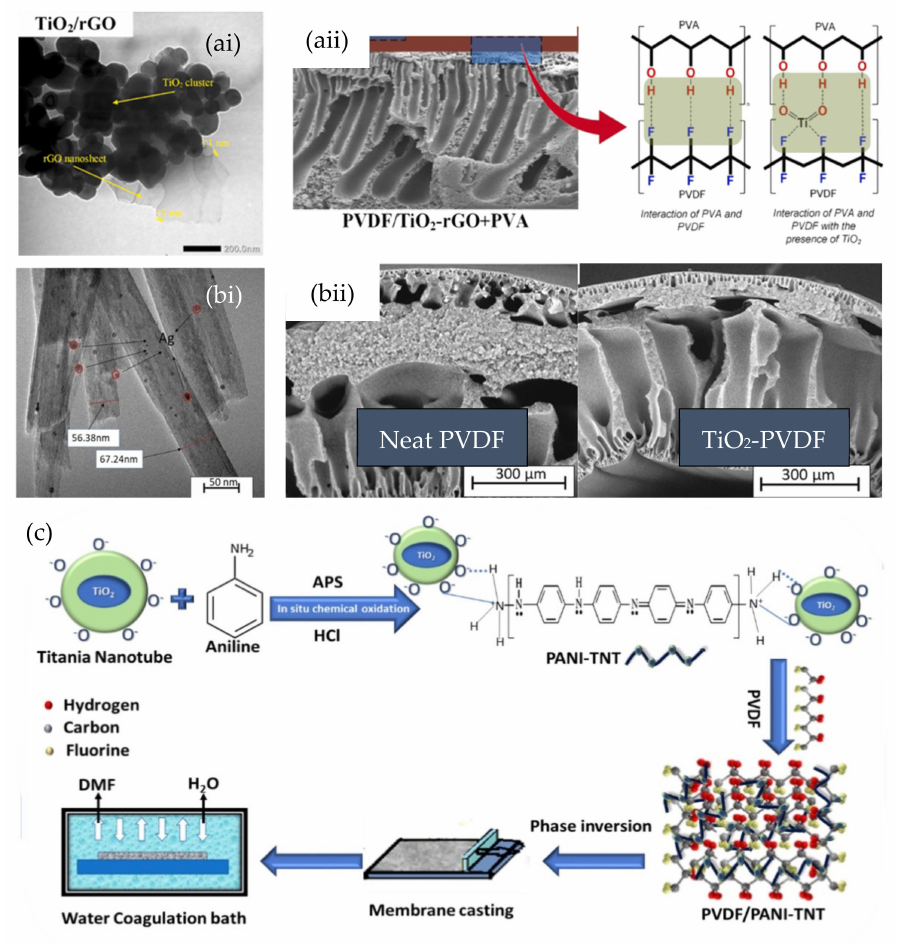
Figure 5. ( ai ) Morphology of rGO/TiO 2 : ( aii ) interaction between PVA − TiO 2 − PVDF in nanocom- posite membrane [133]; ( bi ) surface morphology of Ag − doped TiO 2 nanotubes; ( bii ) cross − sectional morphology of neat dual − layer PVDF membrane and nanocomposite membrane incorporated with Ag − doped TiO 2 nanotubes [136]; ( c ) schematic flow of the preparation of PVDF nanocomposite inorporated with PANI − functionalized TiO 2 nanotube [137]. Reprinted with